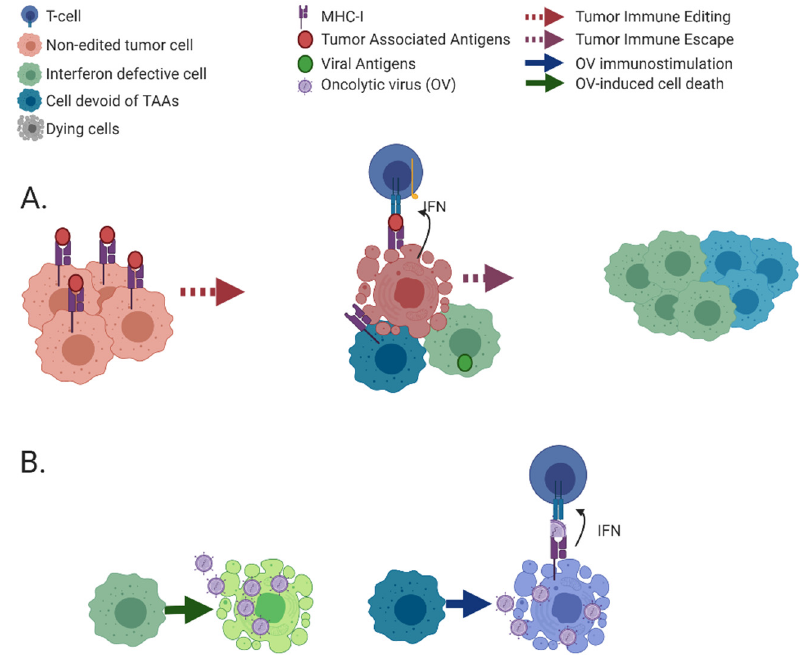
Figure 2. Tumor immunoediting and treatment of escape mutants with oncolytic viruses. ( A ) Tumor cells prior to editing are depicted (in pink) at the left side. Anti-tumor immunity kills a portion of susceptible tumor cells while selecting for escape mutants (middle), allowing their subsequent clonal expansion (right). Two types of escape mutants are depicted: green—IFN-defective cells, blue—cells devoid of tumor-associated antigens. ( B ) OV treatments (e.g., by naturally oncolytic viruses, see Section 5 for definition) of the immunoedited tumors (described in A). Direct cell killing by OVs (left), immune-mediated killing of infected cells (right). A number of such naturally oncolytic viruses are now under clinical trials for treatment of diverse cancer types. The figure was created with BioRender.com (accessed on 12 February 2021).